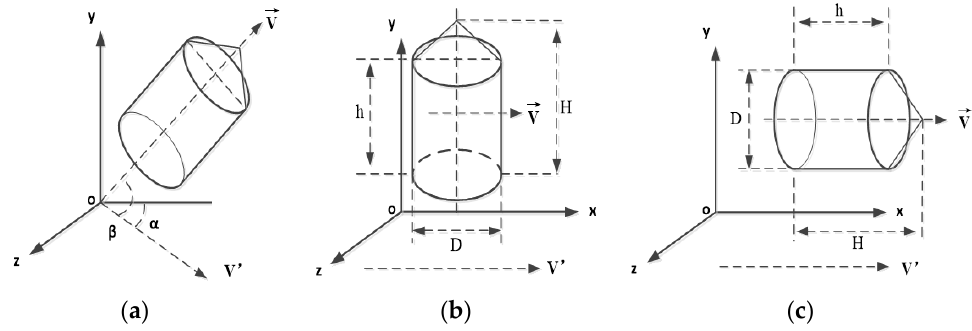
Figure 7. Fragment flight orientation. ( a ) The first flight orientation. ( b ) The second flight orientation. ( c ) The third flight orientation.